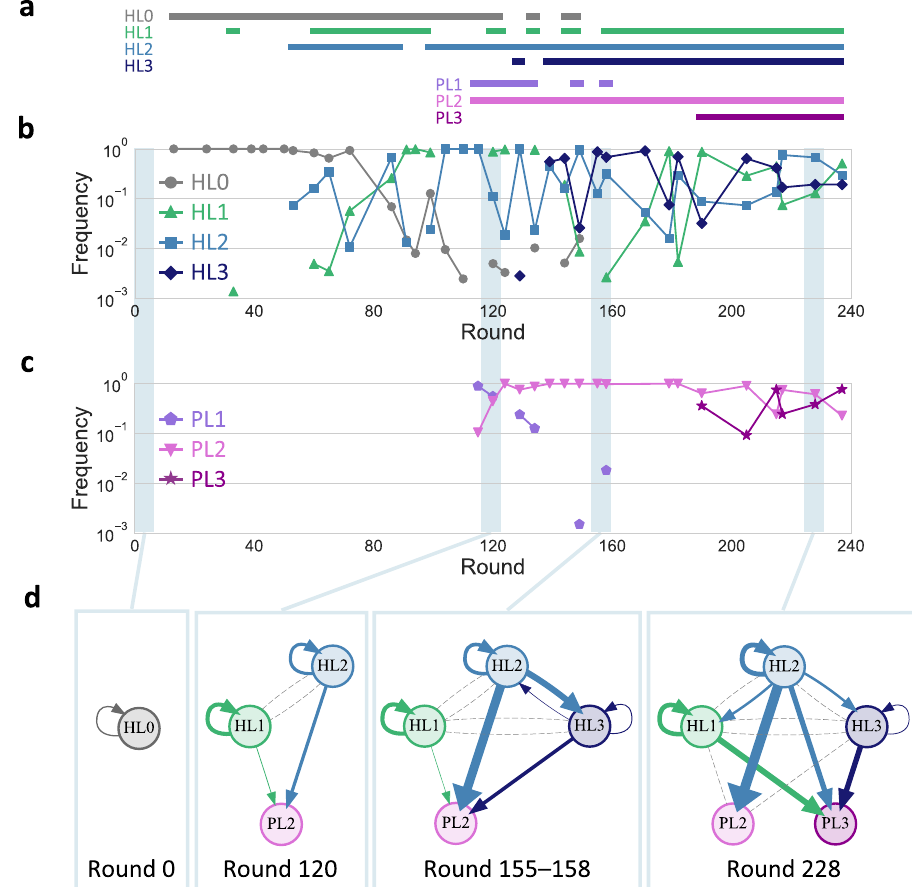
Fig. 3 Development of replicator networks. a – c Frequencies of the lineages in total sequence reads of the analyzed genotypes for the host ( b ) and parasitic ( c ) RNAs, with horizontal lines above the graphs ( a ) indicating rounds where the frequency of each lineage is more than 0.1 %. d Directed graphs based on translation-uncoupled experiments (Fig. 4) for representing inter-dependent replication of the RNA clones of each selected round. Nodes represent RNA clones of indicated rounds. Arrows indicate direct replication with widths proportional to binary logarithm of the measured levels of relative replication. Gray dashed lines indicate undetected replication events from host RNA